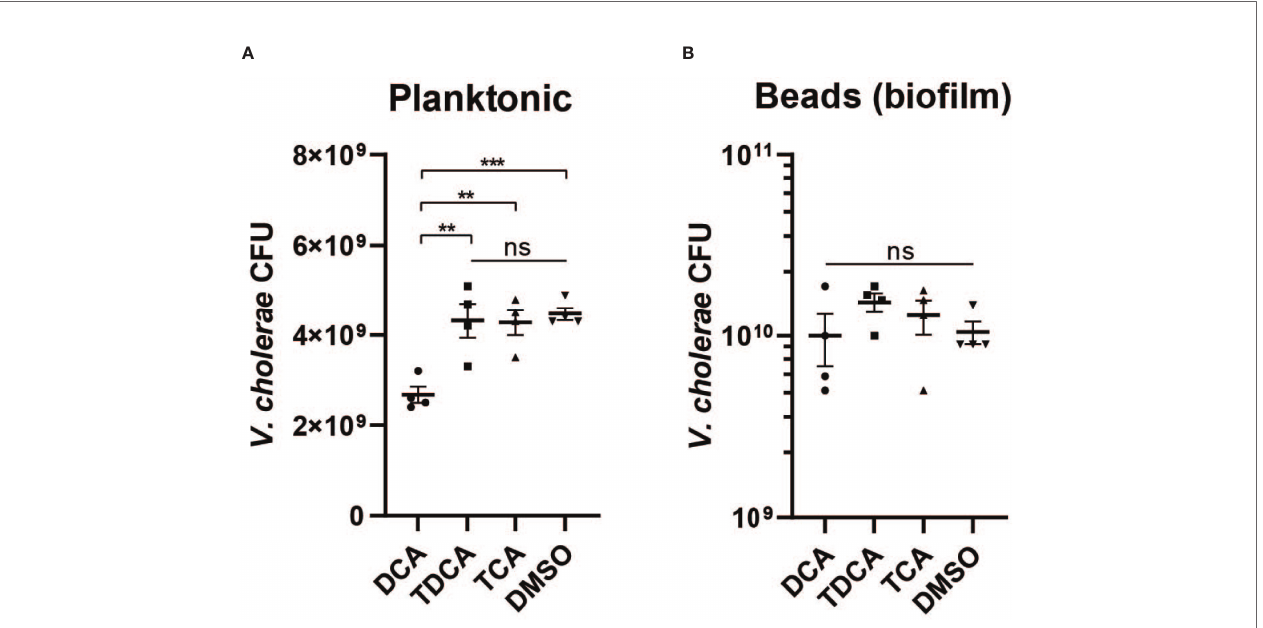
FIGURE 7 | Bio fi lm provides V. cholerae resistance against secondary bile acid deoxycholate. Survival of (A) planktonic and (B) bio fi lm associated V. cholerae after 4 h of incubation with 1 mM of different bile acids including conjugated bile acids taurocholate (TCA) and taurodeoxycholate (TDCA), and the deconjugated secondary bile acid deoxycholate (DCA) (n = 4, T-test, **P < 0.01, ***P < 0.001; ns, not signi fi